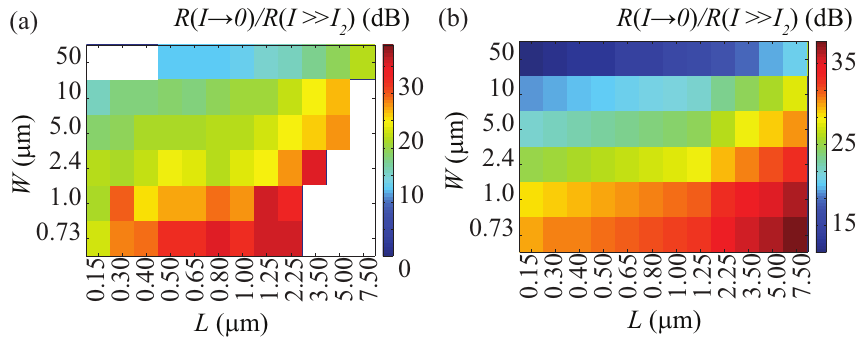
Figure B2. The ( a ) measured and ( b ) calculated change in the resistance of VO function of L and W